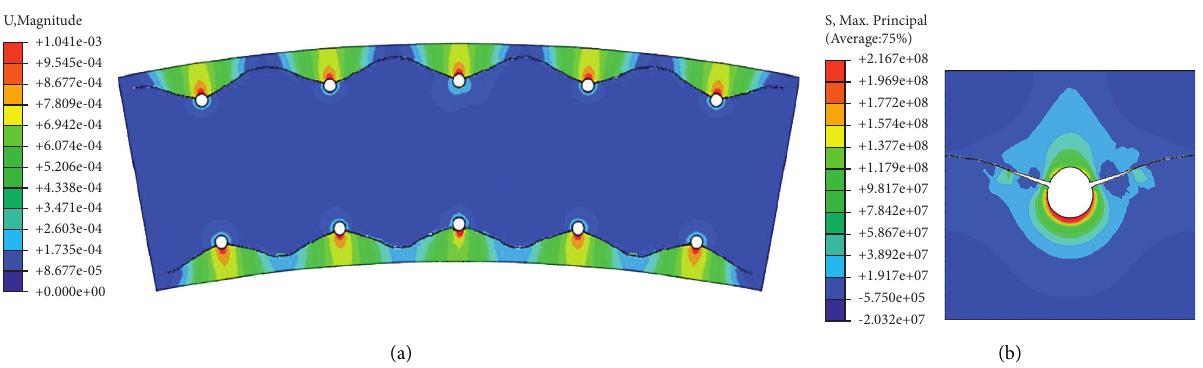
Figure 17: Degradation characteristics of the segment after 20 years of steel bar corrosion: (a) the displacement cloud during cracking and (b) the maximum principal stress cloud during cracking (deformation amplification factor is